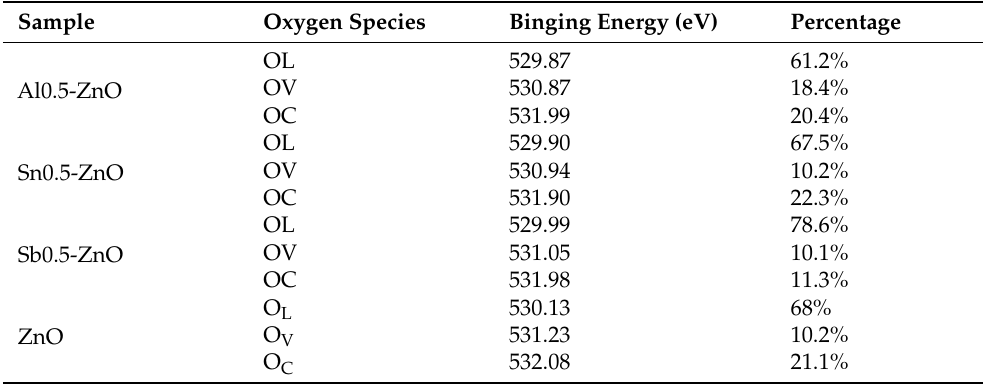
Table 2. Fitting results of O 1s XPS spectra of ZnO NPs and different cations (Al 3+ , Sn 4+ , and Sb 5+ ) doped ZnO NPs.